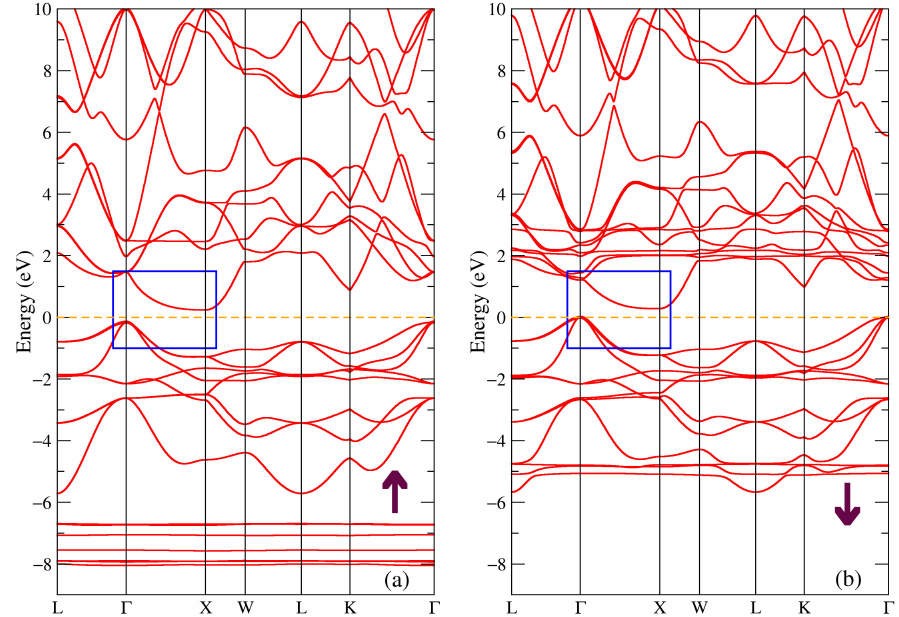
Figure 9. Band structure of HoNiSb: ( a ) majority and ( b ) minority spin projections. The blue rectangle points out the bands involved in the band gap formation.